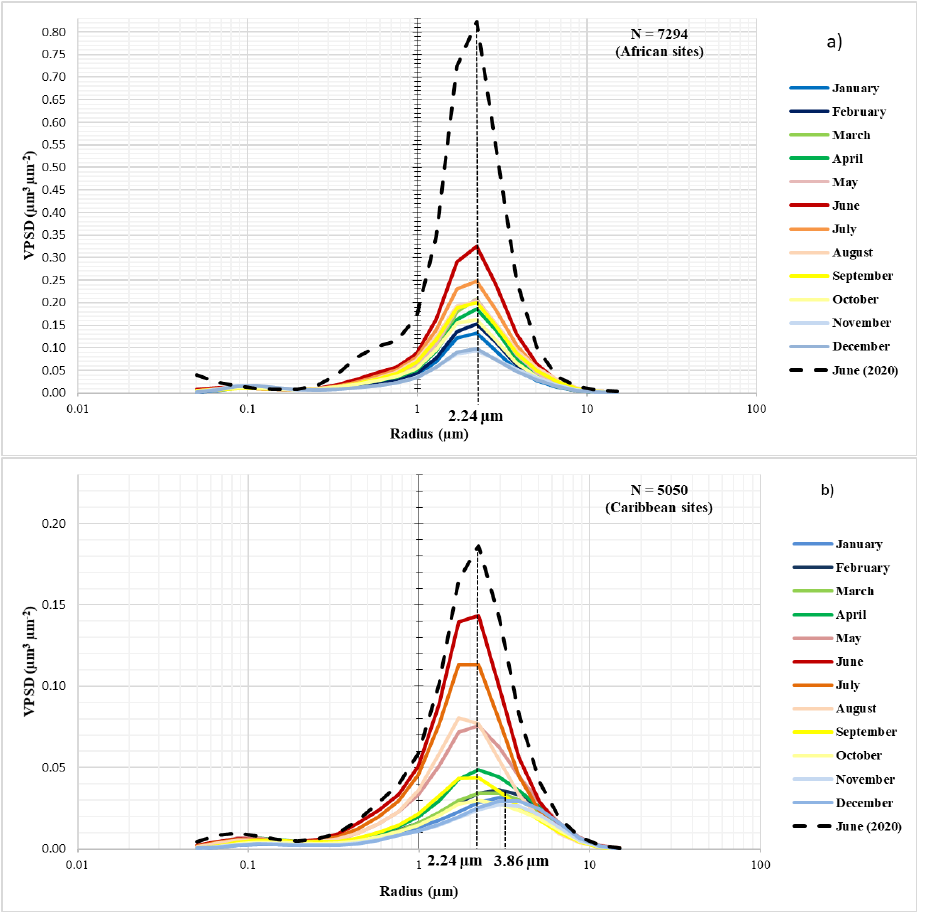
Figure 5. Volume Particles Size Distribution (VPSD) [ dV ( r ) / dln ( r ) ( µ m 3 µ m − 2 )] of monthly data for ( a ) African sites (Capo Verde and Dakar) and ( b ) Caribbean sites (PR, GPE, and BAR) from 1996 to